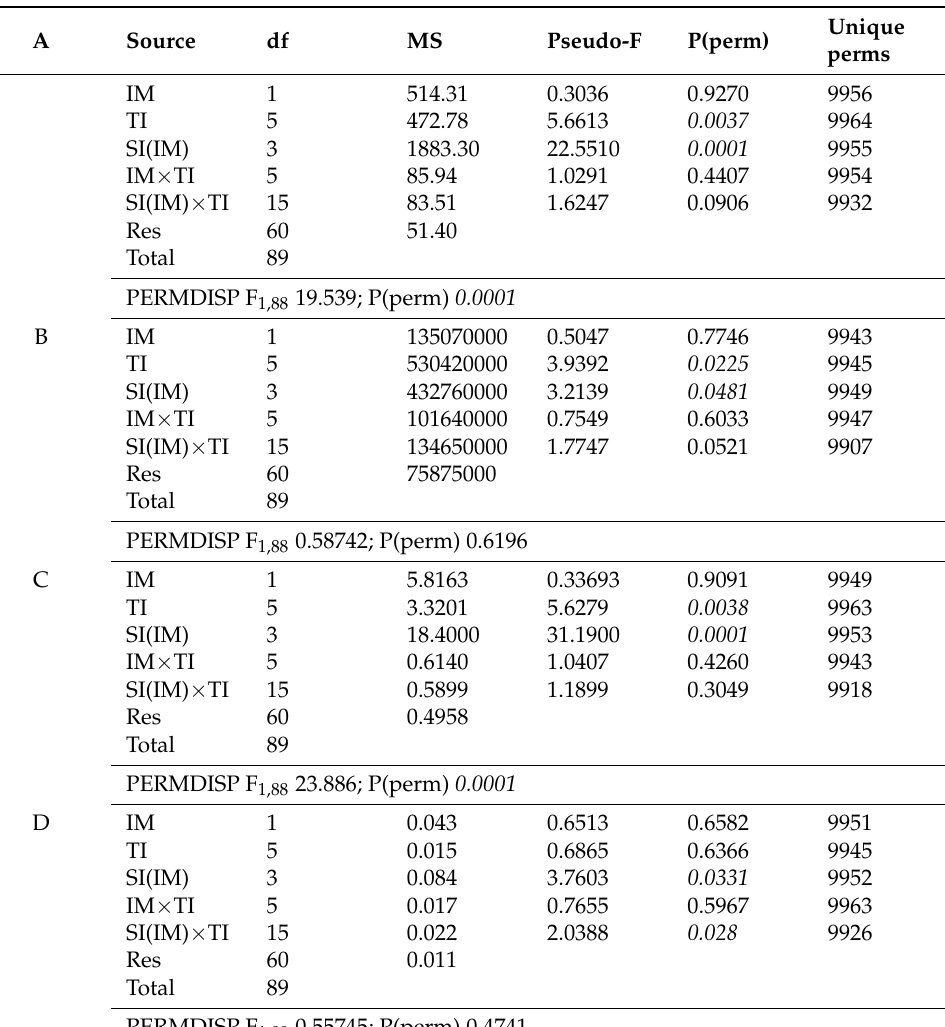
Table 4. The ANOVAs testing difference in species number (A), abundance (B), species richness (Margalef) (C), and evenness (Pielou) (D) in hard-bottom polychaete assemblages in the study areaPer each test, the result of the PERMDISP is also provided. IM, impact; SI, site; TI, time. Significant p -values are given in italics. MS, mean squares; Pseudo-F, statistic; P(perm), probability calculated by permutations; unique perms, unique permutations. 9999 permutations were